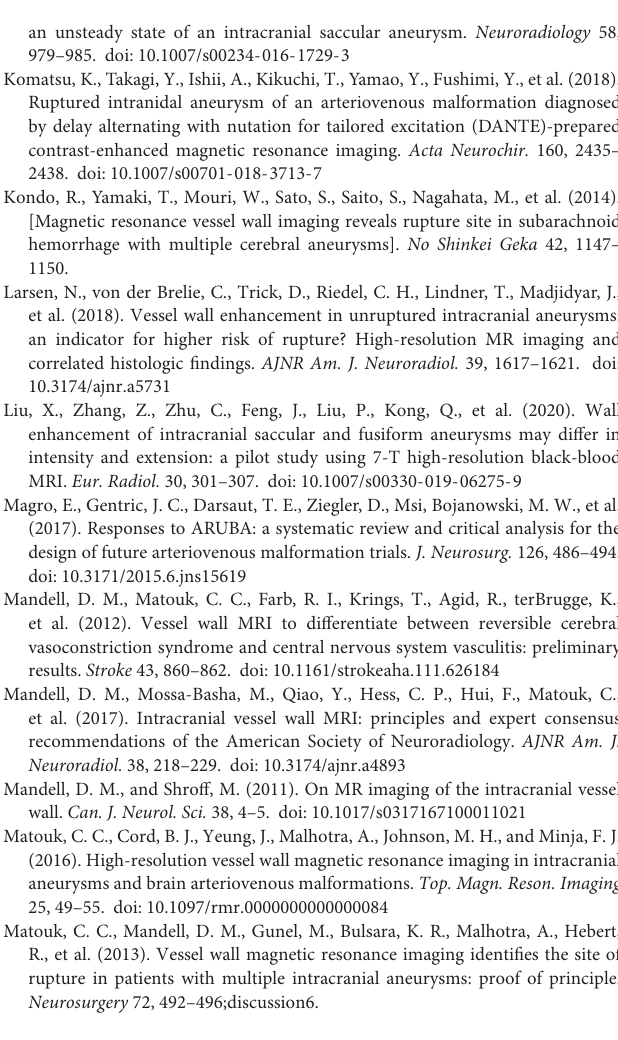
Supplementary Figure 1 | 30-year-old female with a predominantly left occipital AVM. On pre-contrast VW-MRI (A) , no intrinsic T1 hyperintensity is present. On post-contrast VW-MRI (B) , there was only one area of hyperintensity near the vessel wall (yellow arrow). No perivascular hyperintensity was present. Supplementary Figure 2 | 24-year-old male with a left frontoparietal AVM. On pre-contrast VW-MRI (A) , no intrinsic T1 hyperintensity is present; however, there were multiple areas of hyperintensity at the vessel wall (yellow arrows) on post-contrast VW-MRI (B) . No perivascular hyperintensity was